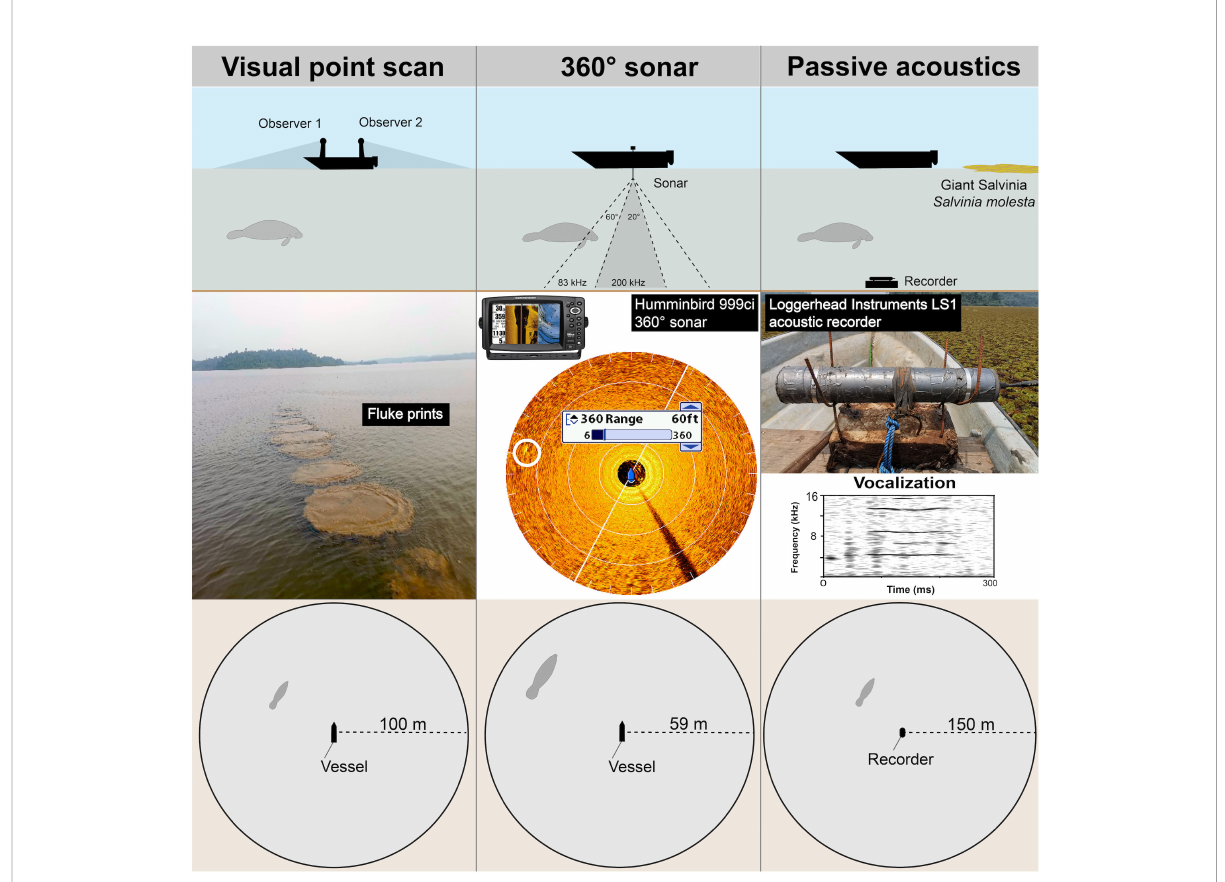
FIGURE 3 Schematic comparison of the procedures involved in each of the three survey methods for detecting African manatees. The three top images illustrate in-situ experimental design for each method. The three center images show some cues for each method, e.g., manatee footprint for visual point scan (center left image), manatee sonar image for 360° sonar scan (center middle image; manatee in the white circle) and a spectrogram of a manatee vocalization for passive acoustics (center right image). The three bottom images illustrate detection ranges for the three